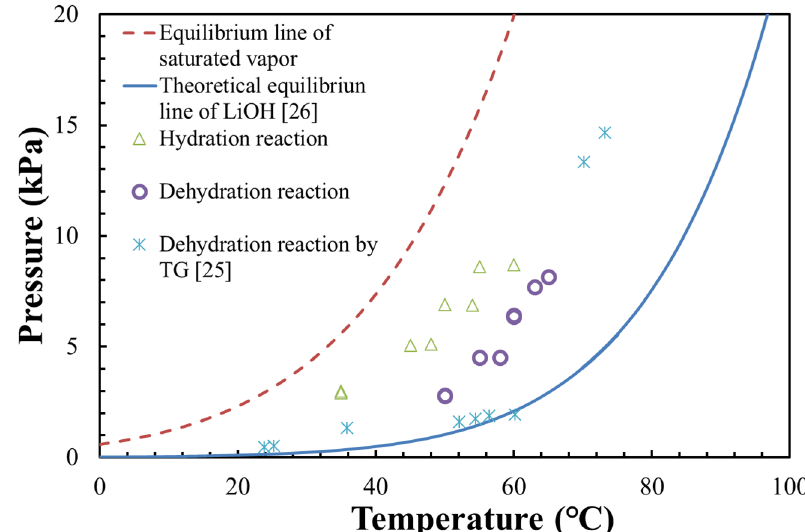
Figure 5. Results of the equilibrium line of LiOH (compared with results from the thermal gravity method [25] and theoretical equilibrium in the previous study [26]).